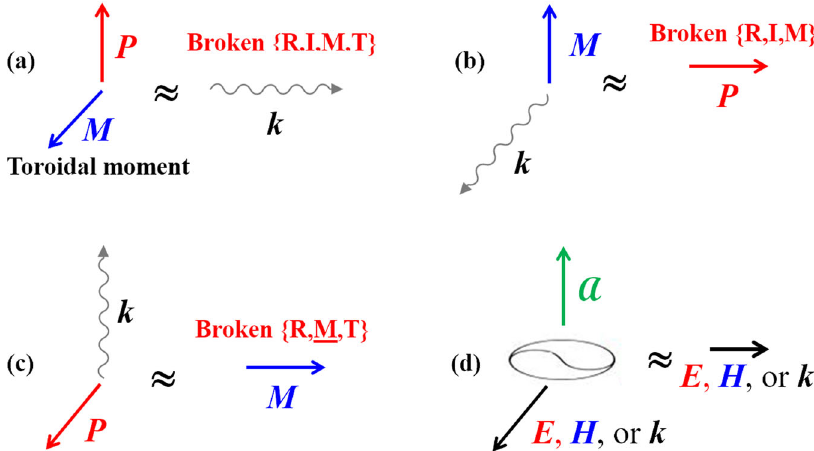
a a 0 ; P , and P 0 and SOS relationships with Fig. 3 Three permutable SOS among . Magnetization ( M or magnetic fi eld H ), polarization a 0 ; P , and P 0 , respectively. a P × M has broken { R , I , M , T } along the horizontal ( P or electric fi eld E ), and velocity ( k ) are representative for direction in the page plane, so has SOS with k . b M × k has broken { R , I , M } along the horizontal direction, so has SOS with P . c k × P has a has broken { R , I , M} along the horizontal direction, so has SOS with broken { R , M , T } along the horizontal direction, so has SOS with M . d E × a a P , H × has broken { R , M , T } along the horizontal direction, so has SOS with M , and k × has broken { R , I , M , T } along the horizontal direction, so has SOS with k